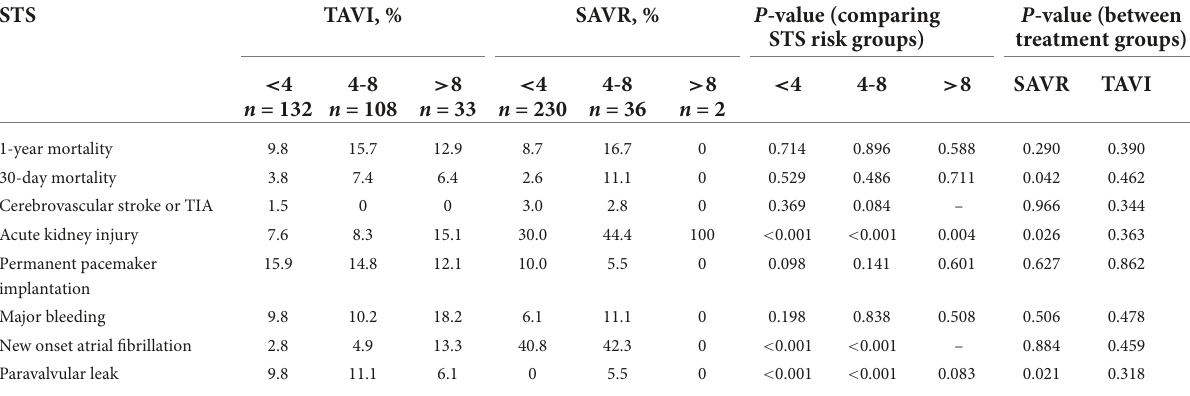
TABLE 5 Outcomes after STS stratification according to TAVI or SAVR.